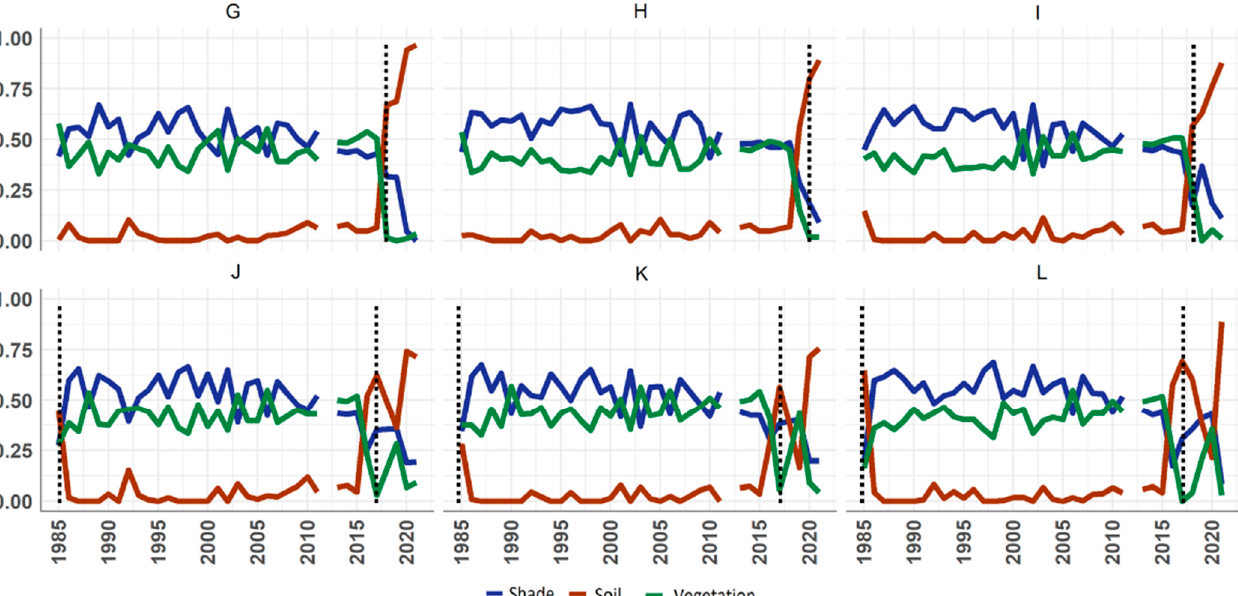
Figure 10. Phenological assessment of Pinus elliottii plantations samples ( G – L ) in the Itapetininga Experimental Station area during the 1985—2021 period based on the fraction-image time series. Analyzing these results, it is possible to identify eucalypt and pine plantation areas through the areas classified. For eucalypt, it is also possible to detect the planted dates of the stands according to the fraction-image time